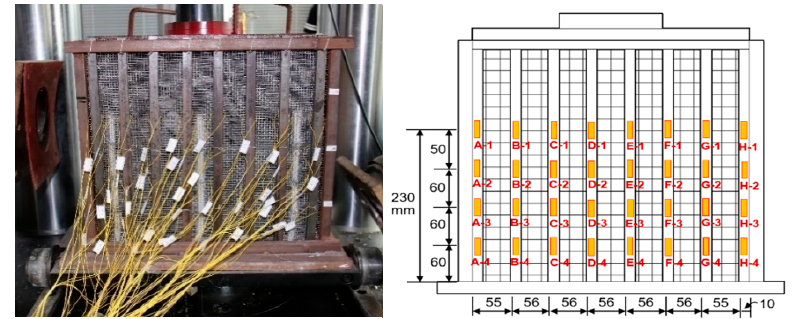
Figure 5. The specific locations and numbering of the strain gauges in tests.